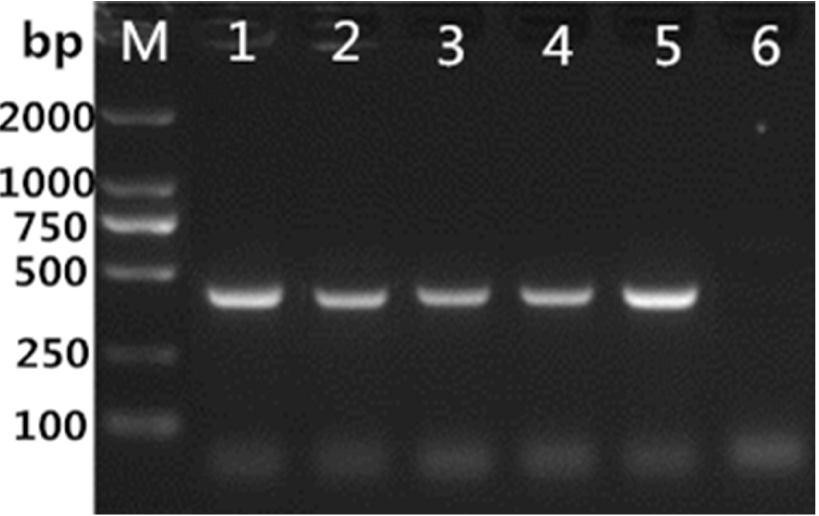
Figure 2. RT-PCR detection of JEV isolates. M: DL2000 DNA marker; 1: CH/GD2015/2015; 2: CH/GD2011/2011; 3: CH/GD2014/2014; 4: CH/GD2018/2018; 5: positive control; 6: negative control.